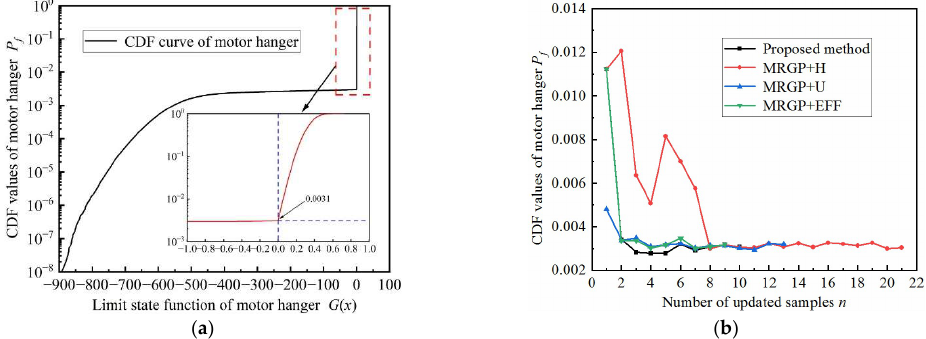
Figure 8. Reliability analysis results of the motor hanger under multiple failure modes. ( a ) CDF curve of the motor hanger; ( b ) Iterative curve of CDF. of the motor hanger; ( b ) Iterative curve of CDF. Table 3. Results of example 4.4 with different methods. Table 3. Results of example 4.4 with different